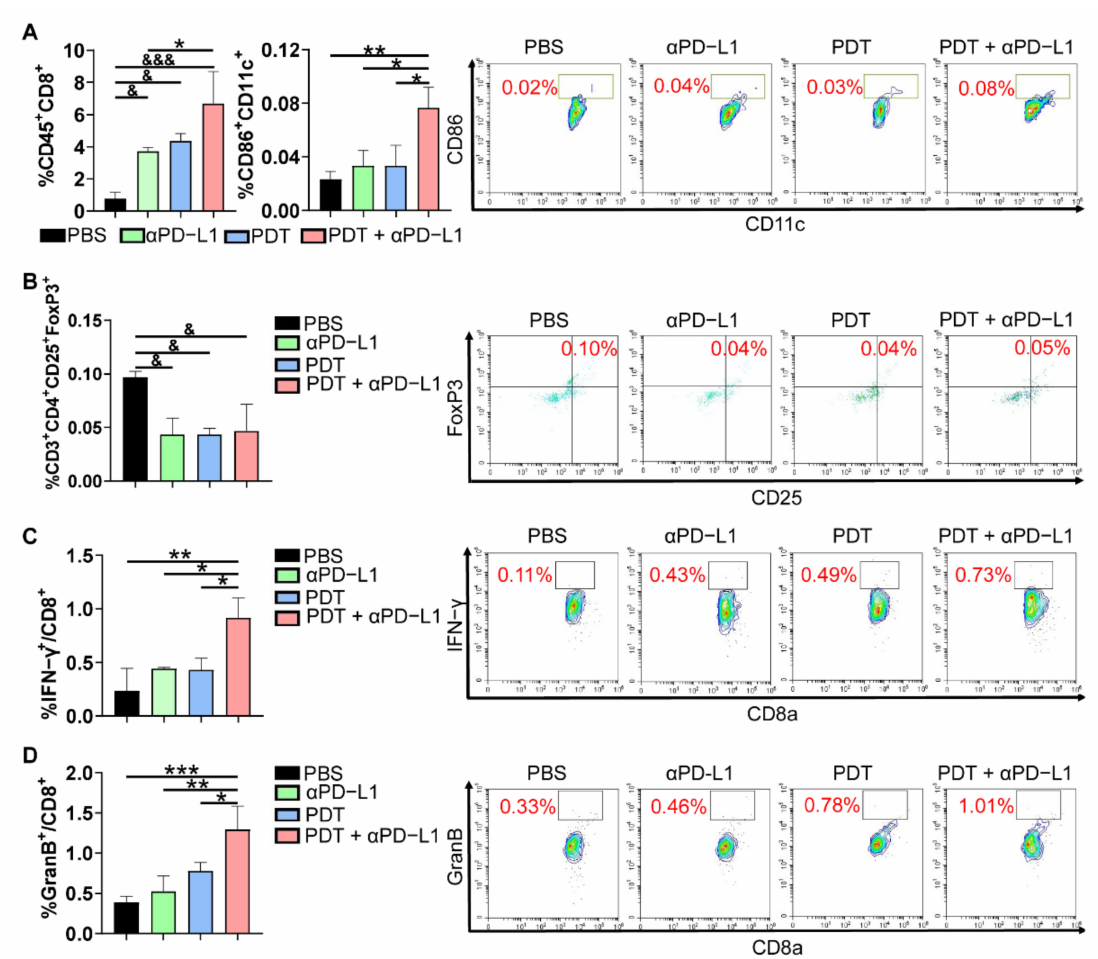
Figure 8. Flow cytometry analysis of various immune cells in the tumors following the treatment. Percentage of CD45 + CD8 + cells and mDCs ( A ), Tregs (CD3 + CD4 + CD25 + Foxp3 + ) ( B ), IFN– γ + in CD8 + cells ( C ) and CD8 + GranB + cells ( D ) in the tumors. The therapeutic regimen was shown in Supplementary Figure S5. The representative flow cytometric histograms and their gating strategies are shown on the right. Data are presented as mean ± SD, n = 3. * p < 0.05, ** p < 0.01 and *** p <